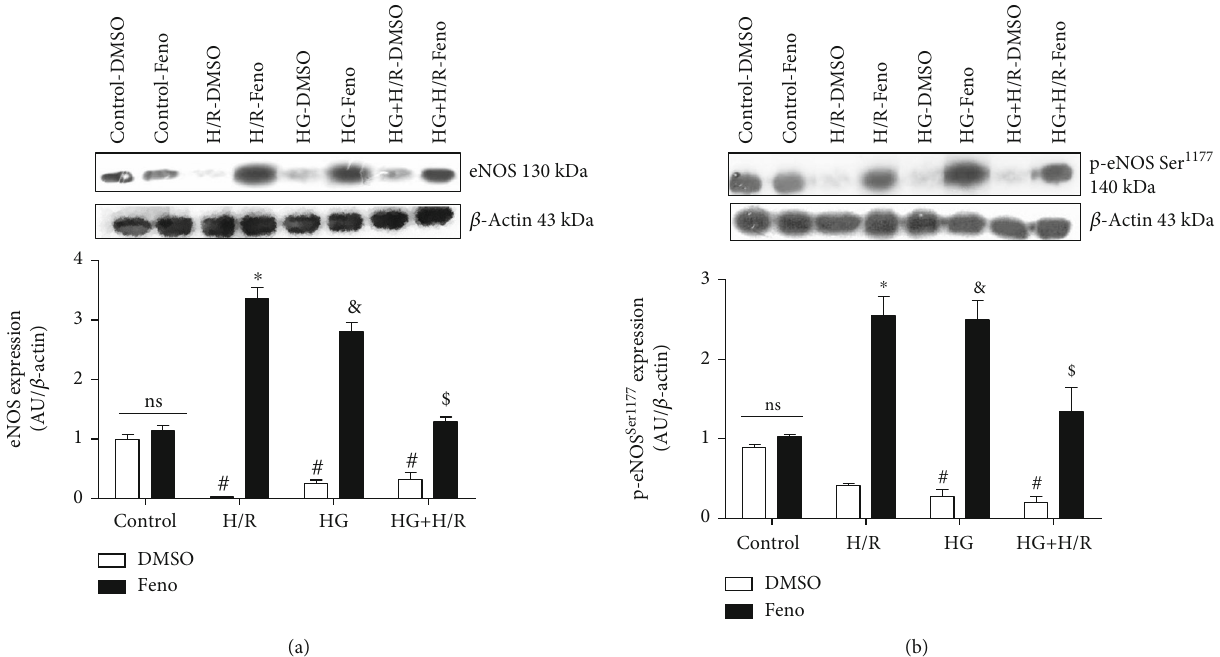
(b) Figure 8: Feno fi brate (10 μ M) increases the expression of endothelial nitric oxide synthase (eNOS) and p-eNOS Ser1177 in primary cultures of cardiomyocytes undergoing hypoxia/reperfusion (H/R), high glucose (HG), and HG+H/R. Protein expression and densitometric analysis of (a) total eNOS and (b) phospho-eNOS Ser1177 were performed. DMSO = dimethylsulfoxide (0.1%); Feno = feno fi brate (10 μ M). # p < 0 : 05 vs. control-DMSO; ∗ p < 0 : 05 vs. H/R-DMSO; & p < 0 : 05 vs. HG-DMSO; $ p < 0 : 05 vs. HG+H/R-DMSO. Values represent the mean ± SEM of 6 di ff erent experiments. Two-way analysis of variance (ANOVA) followed by Tukey ’ s post hoc test.